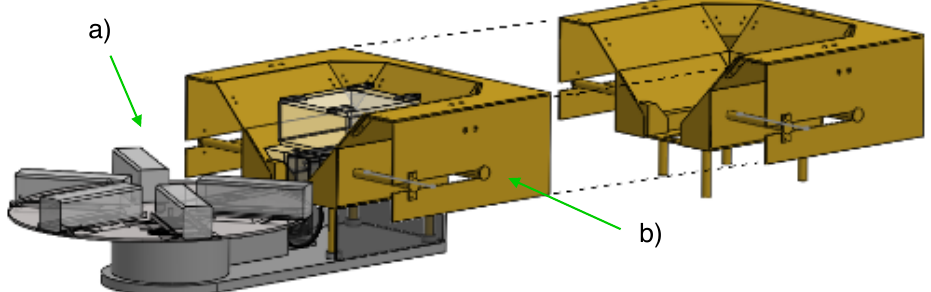
Figure 5. Non-actuated landing surface design: ( a ) battery storage and ( b ) sloped landing surface.